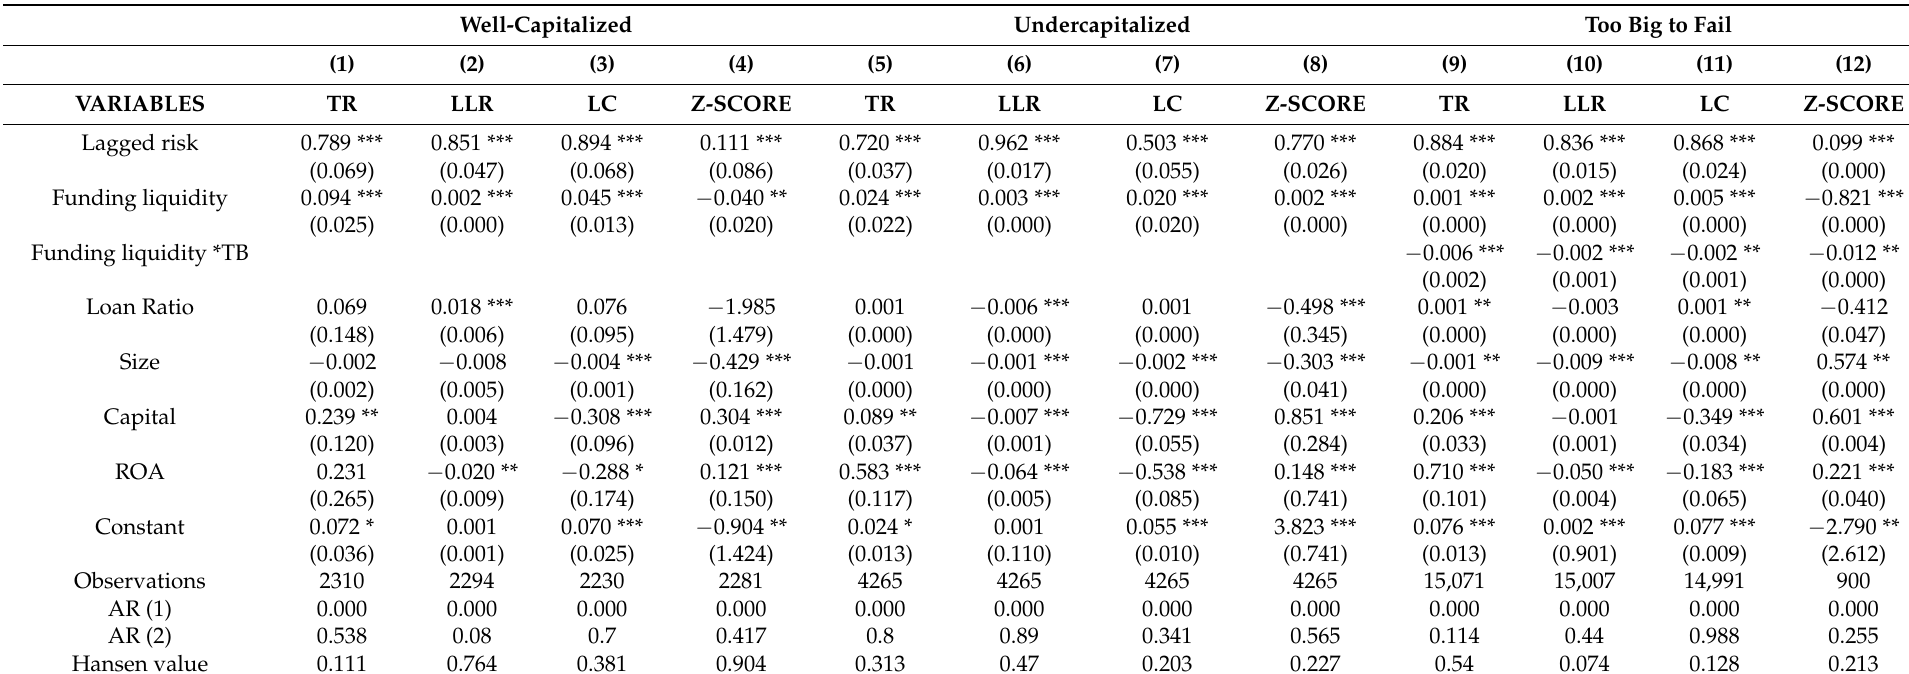
Table 4. Funding liquidity ratio and risk varies across banks